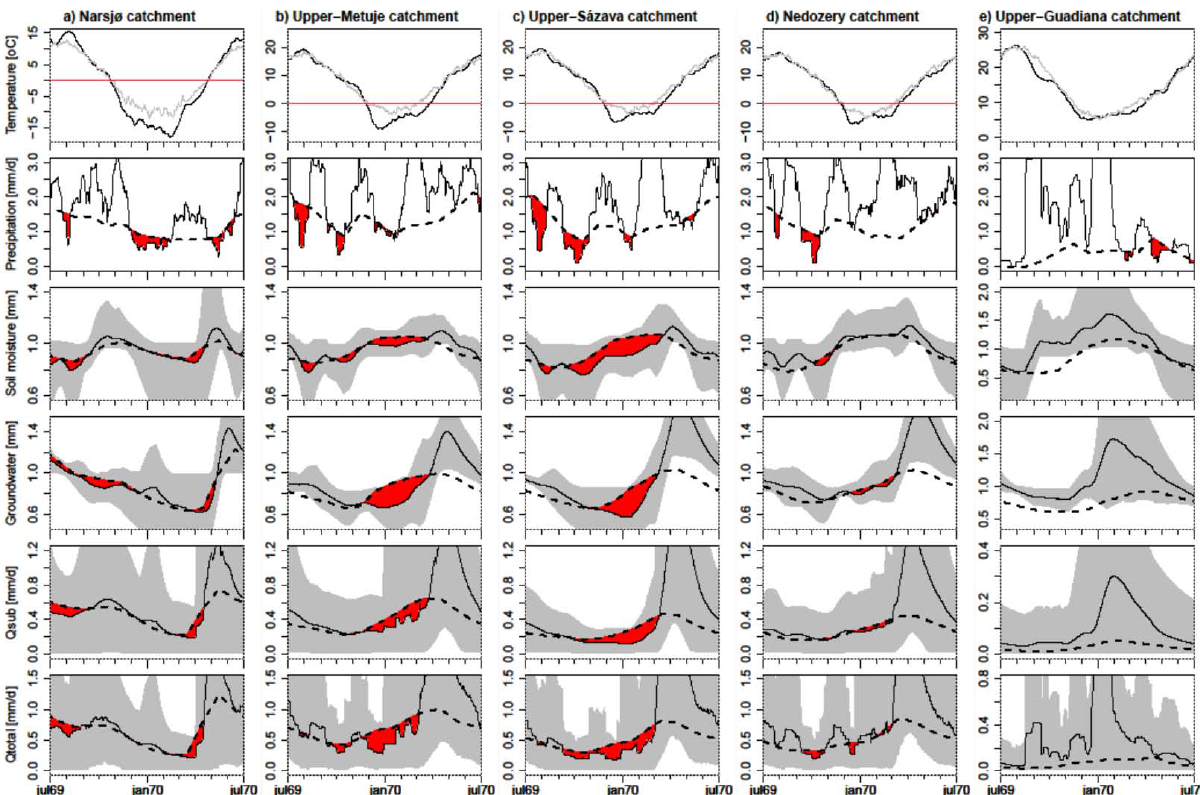
Fig. 3. Example of drought events in all case study areas: Narsjø, Upper-Metuje, Upper-S´azava, Nedoˇzery, and Upper-Guadiana in 1970 (all rows: black, solid line = time series of meteorological variable (30-day moving-average of WFD temperature and precipitation) or ensemble mean of hydrological variable (see y-axis), grey area = range of individual models, dashed line = smoothed monthly 80%-threshold of displayed variable, red area = drought event; upper row: grey line = long-term average of WFD temperature, red line = 0 ◦